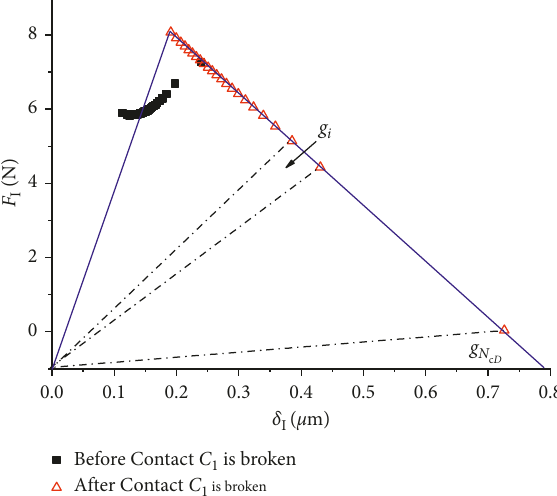
Figure 15: Evaluation of the energy release at the second contact close to the crack tip during a fatigue